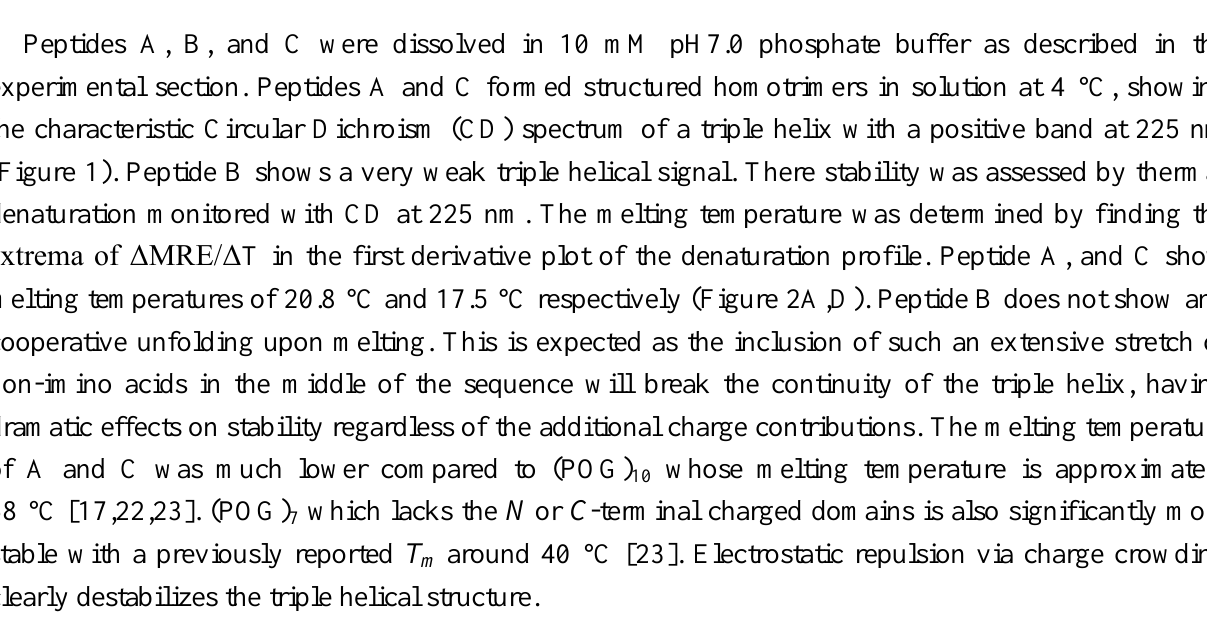
Figure 1. Circular Dichroism (CD) spectra at 4 °C of all 10 mixtures of peptides A, B,